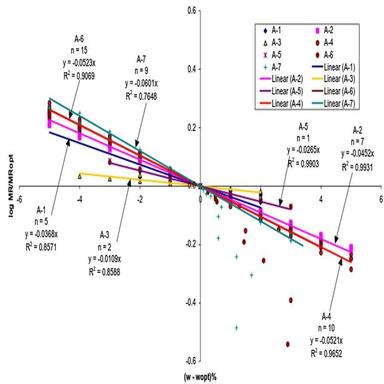
Variation of MR/MROpt with Moisture Content Level for Different Groups of AASHTO Soil Classification System.